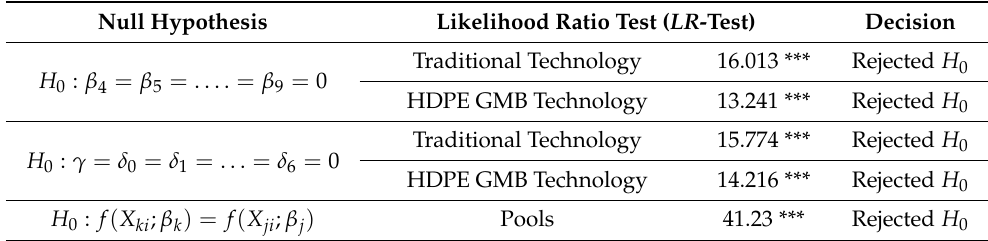
Table 3. Results of the hypothesis testing with LR -test. Null Hypothesis Likelihood Ratio Test ( LR -Test)